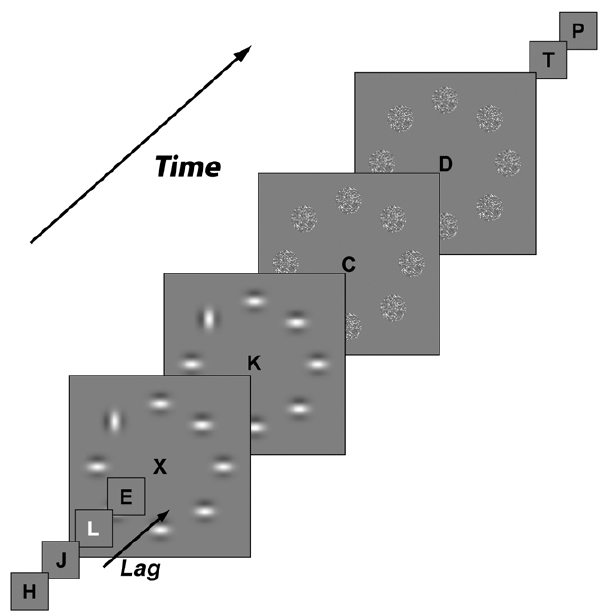
Figure 1. Schematic overview of trial timeline from left to right. Letters were presented for 33 ms alternated by 50-ms blanks. The white target letter (T1) was followed by a lag of 0, 160, 320, or 640 ms, after which a ring of Gabor patches (containing T2) was presented. The ring of Gabor patches and mask screen were on screen for a duration of 160 ms each. Letter size is enhanced for illustration